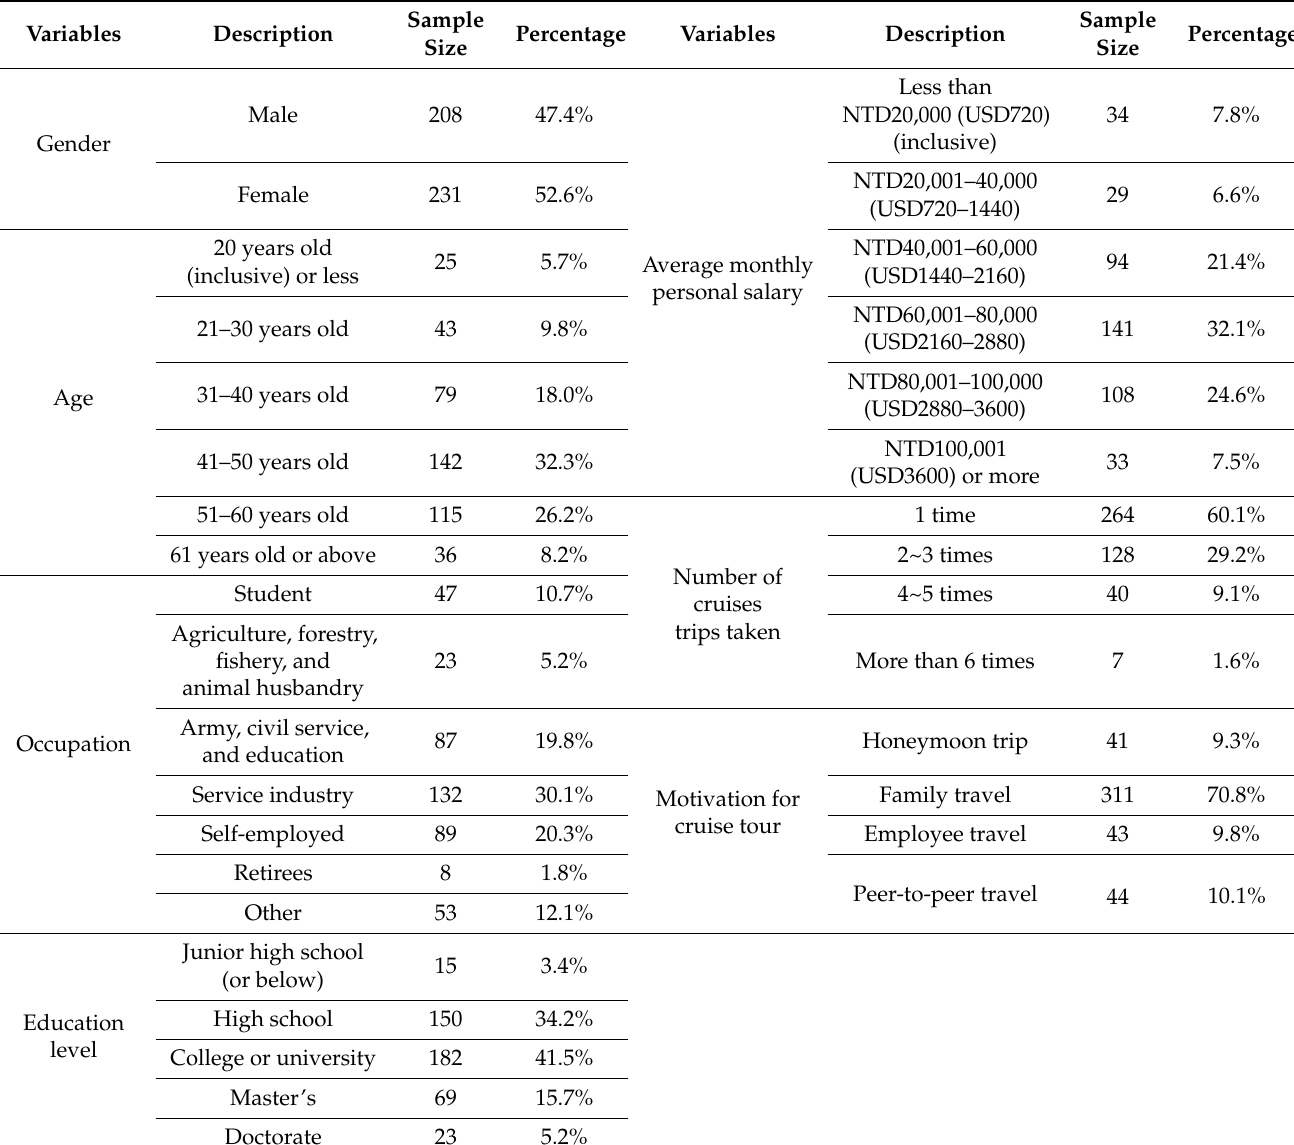
Table 2. Demographic variables and travelers’ experience of cruise